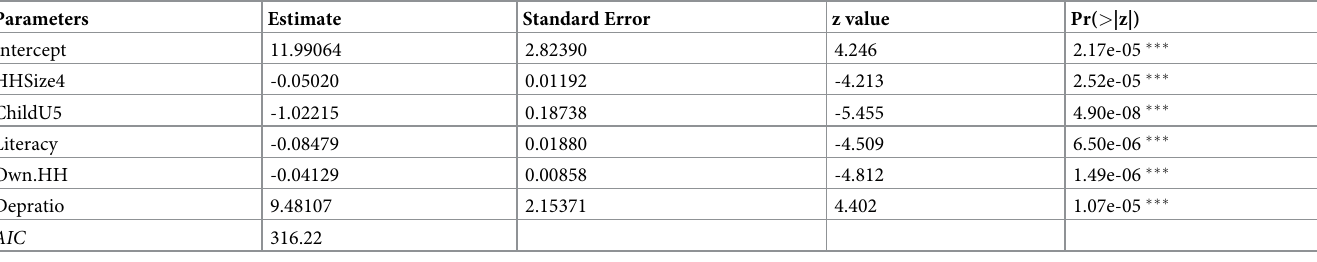
Table 2. Model parameters for the generalised linear models for diarrhoeal